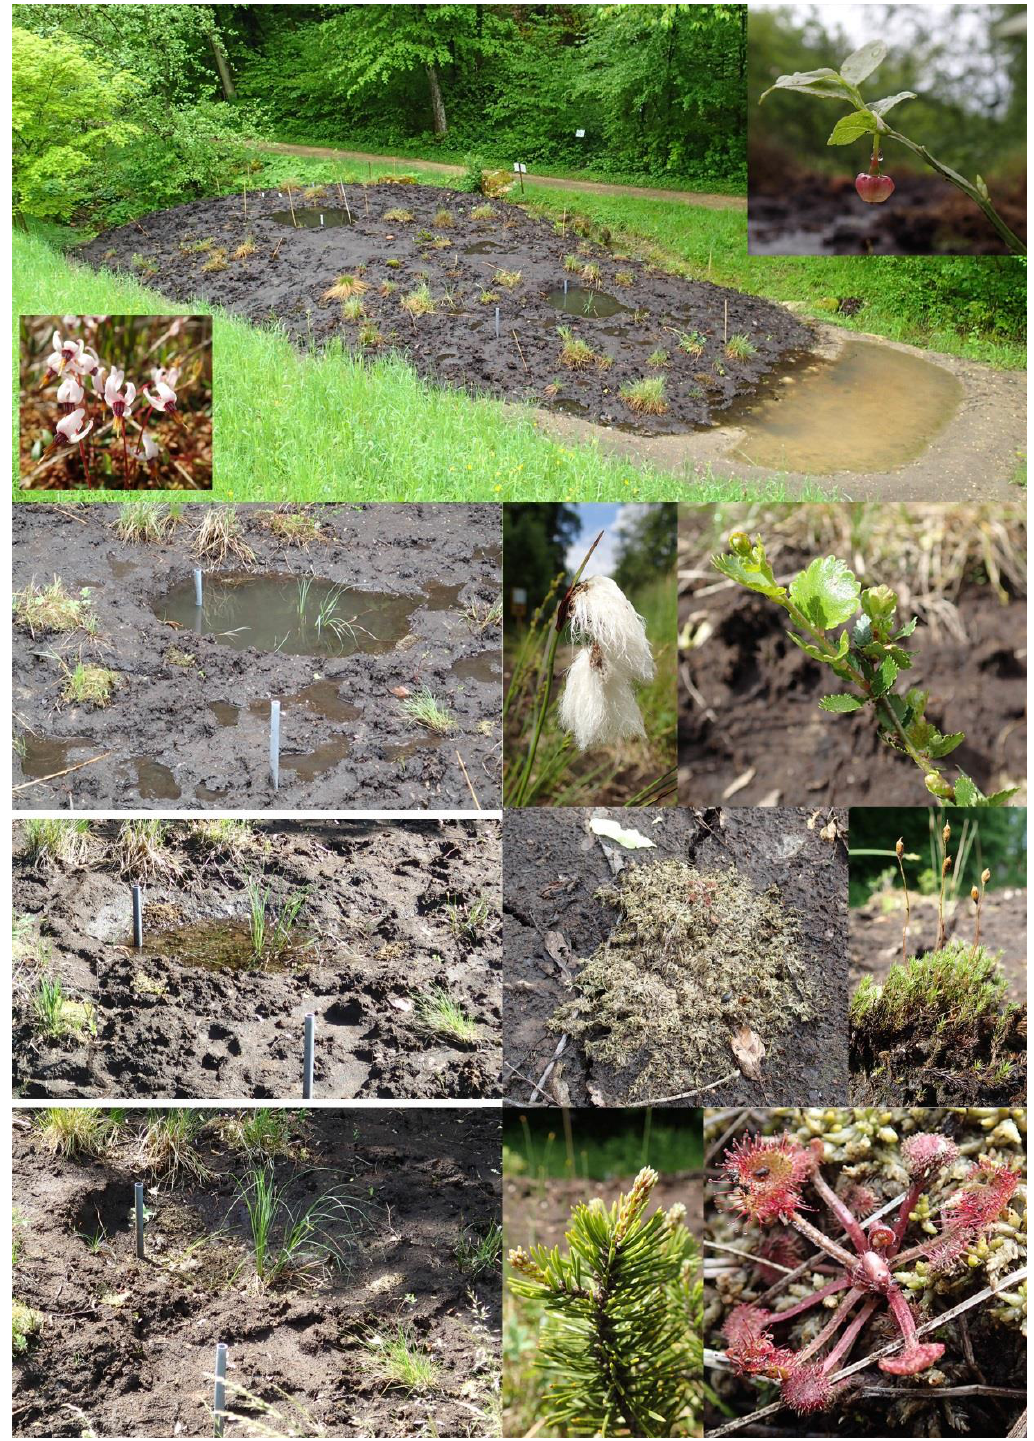
Figure A1. The experimental raised bog at Neuchâtel Botanic Garden in spring 2015. Top: general view on 04 May, during the very wet spring period; right inset: Vaccinium myrtillus ; left inset: Vaccinium oxycoccos . Left-column pictures show gradual drying of the ‘fen’ area from 04 May (top) through 13 May (middle) to 02 June (bottom); during that period, the water table dropped from 19 cm above ground level to 8 cm below ground level. The remaining pictures show (from left to right in each case), top row: Eriophorum vaginatum , Betula nana ; middle row: Sphagnum patch with Drosera rotundifolia and the first cracks appearing on bare peat, Polytrichum strictum ; bottom row: Pinus mugo subsp. uncinata , Drosera rotundifolia